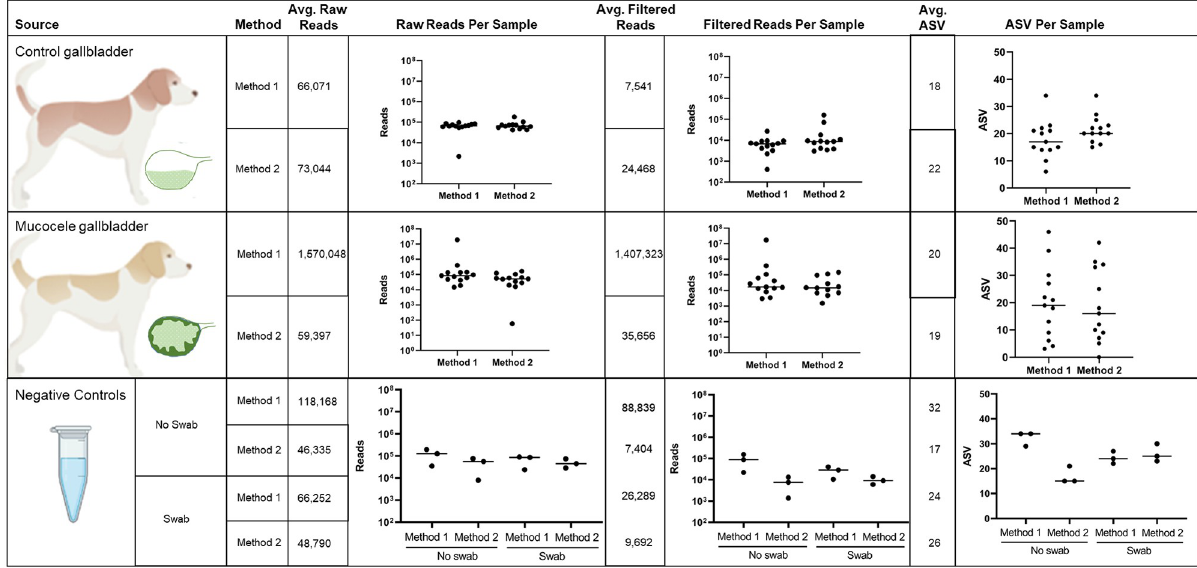
Fig 1. Number of sequencing reads and amplicon sequence variants (ASVs) identified in 13 samples of bile from the gallbladder of healthy control dogs, 13 samples of mucus from the gallbladder of dogs with mucocele formation and 4 negative extraction controls run in triplicate under each of two extraction protocols with or without introduction of a sterile swab. Method 1 DNA extraction performed using phenol. Method 2 DNA extraction performed without use of phenol as described in Methods.